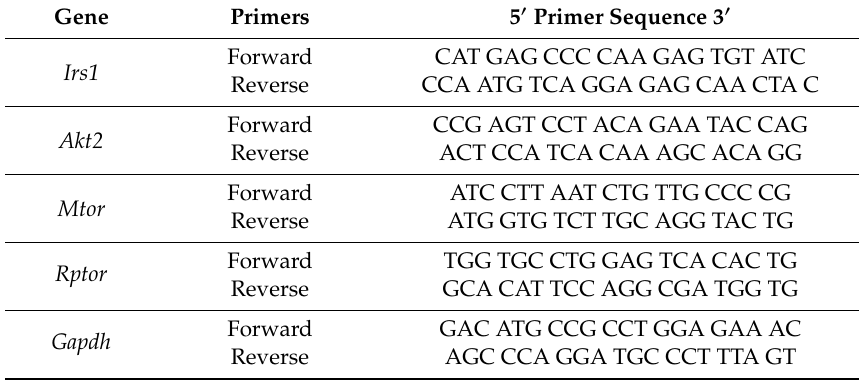
Table 3. Primer sequences used for the analysis of gene expression with real-time